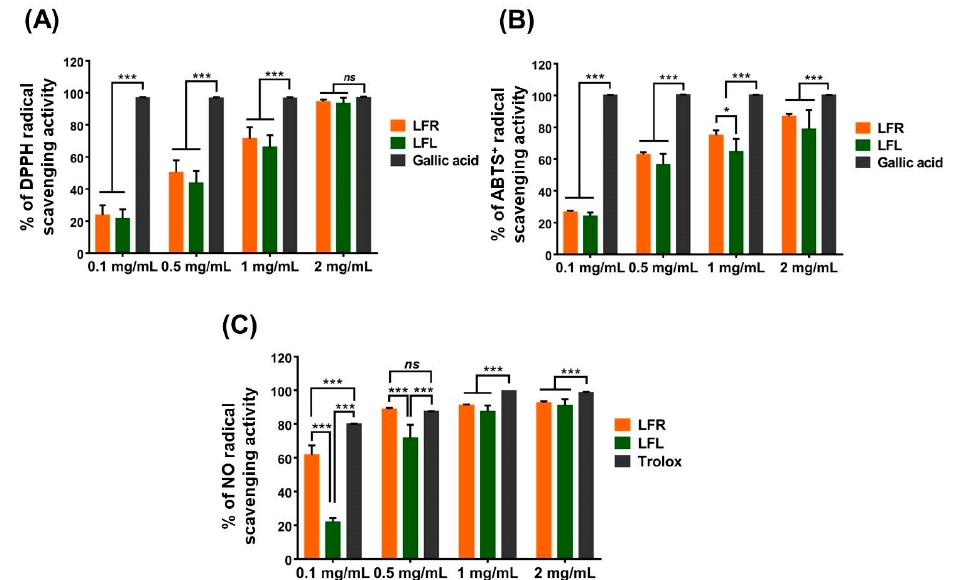
Figure 1. Antioxidant activities of root and leaf extracts from L. fischeri in a cell-free system. ( A ) DPPH, ( B ) ABTS + , and ( C ) NO radical scavenging capacity. Results are presented as the mean ± S.D. of at least three independent experiments. * p < 0.05 and *** p < 0.001 are considered statistically significant differences. LFR and LFL: L. fischeri root and leaf extracts, respectively.